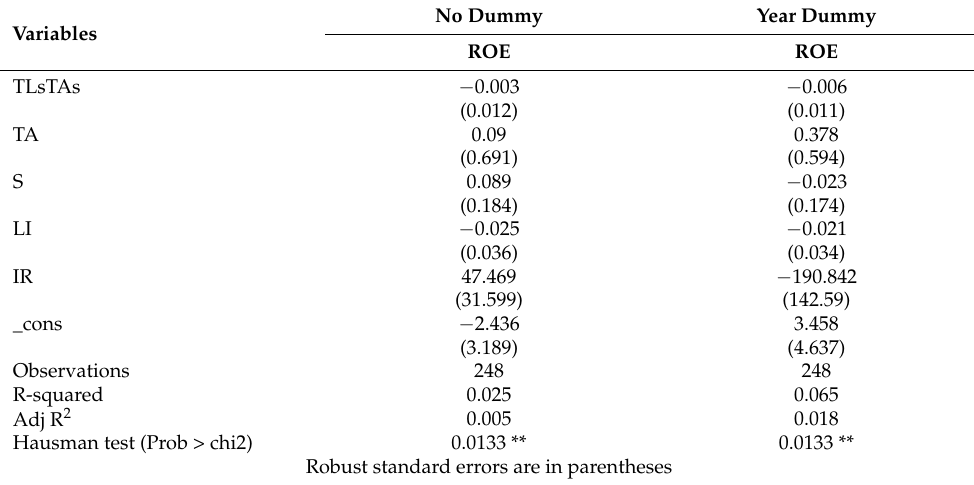
Table 15. Results of the Fixed Effects of TLsTAs on ROE, as per Panel Data Regression (Loss-Making Subsample).